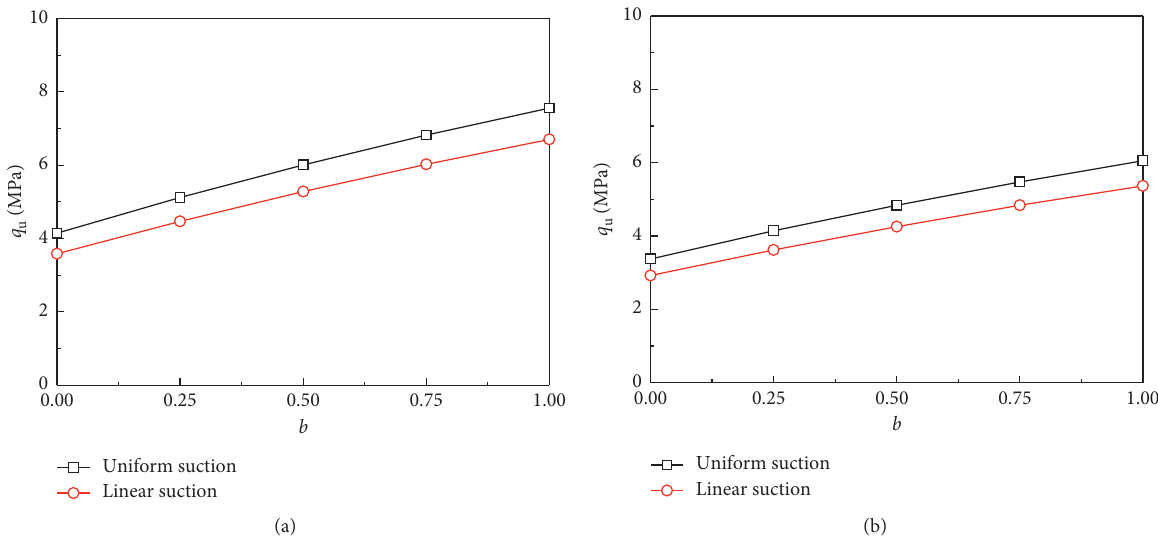
Figure 11: Effect of base roughness. (a) Completely rough. (b) Completely